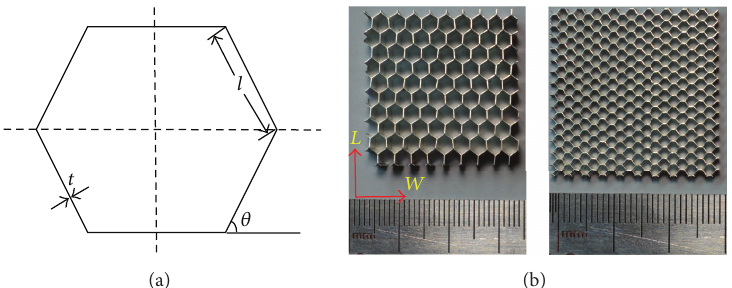
Figure 1: Two kinds of honeycombs applied in tests. (a) Honeycomb cell structure and (b) H1 ( 𝑙 𝑑1 = 1.87 mm) and H2 ( 𝑙 𝑑2 = 1.13